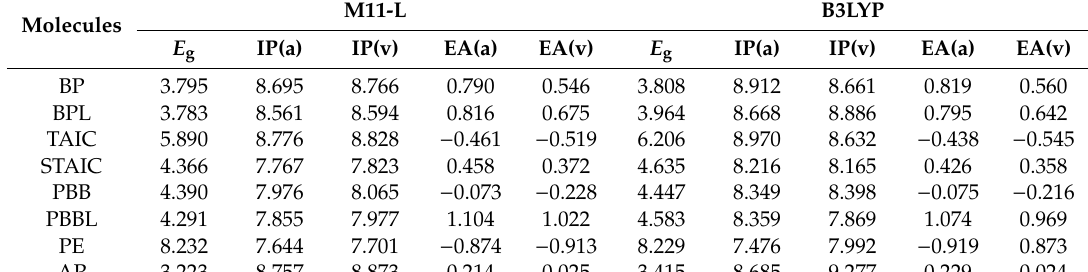
Table 5. Energy band-gap, ionization potential, and electron a ffi nity (all in eV unit) of photon initiators, auxiliary crosslinking agents, and by-products for UV-initiated polyethylene crosslinking reactions. Molecules